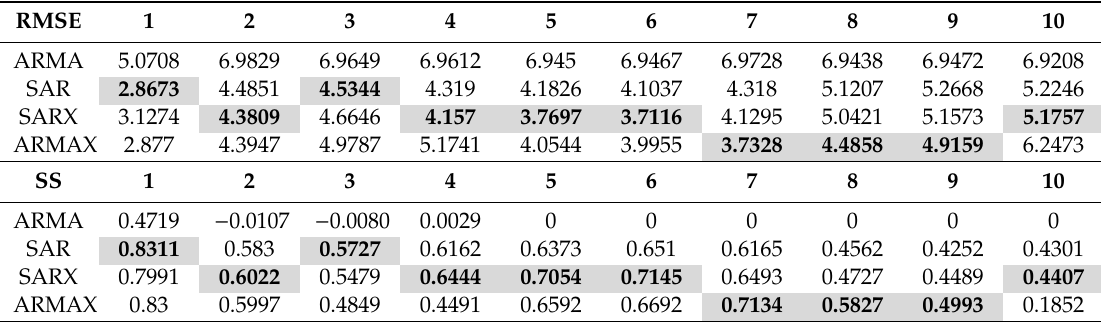
Table 1. Cross-validation results for the four models developed for the annual Colorado River Water Supply data. Root mean squared error (RMSE) is shown on top while the skill score (SS) is shown on the bottom. The columns represent the ten forecasting horizons (h = 1, 2, ... 10). Highlighted values are the best statistic for each forecasting